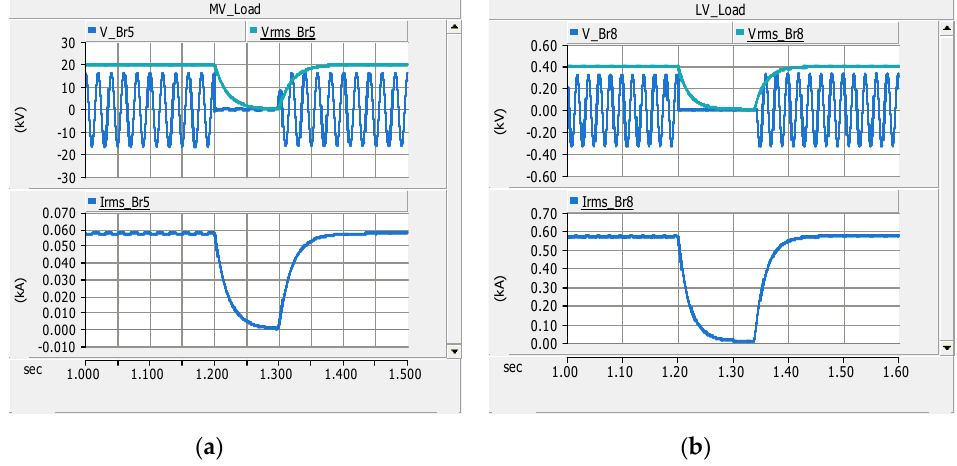
Figure 23. Three-phase RMS voltage, current and single-phase instantaneous voltage at loads before, during and after the fault F2 in the islanded mode at: ( a ) the MV load and ( b ) LV load.